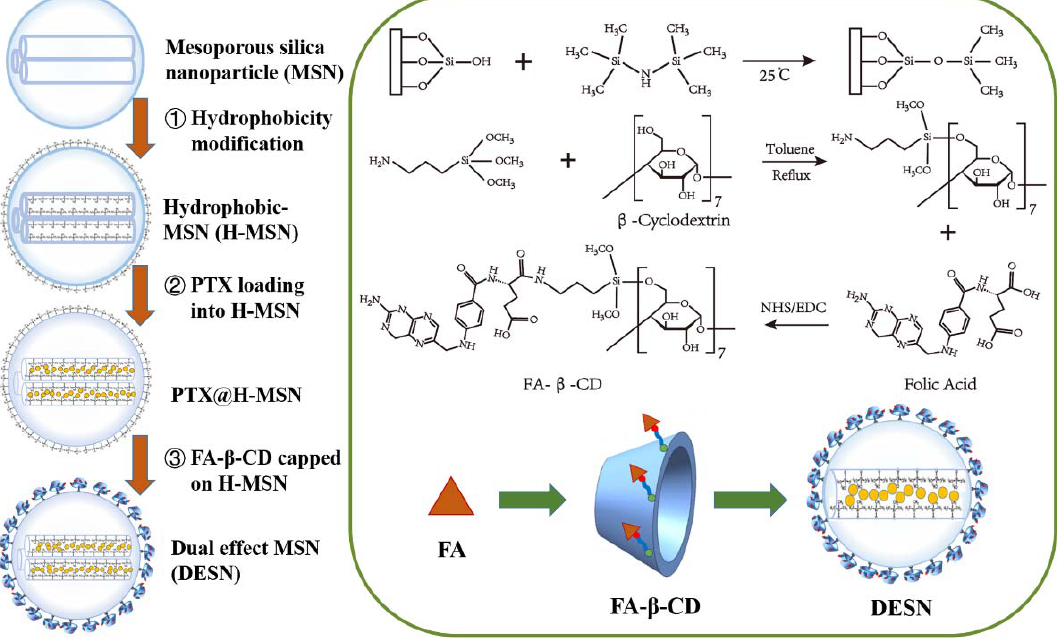
Table 1. Structure parameters, PTX-loading efficiency, and zeta potential of the fabricated samples (MSN, H-MSN, and